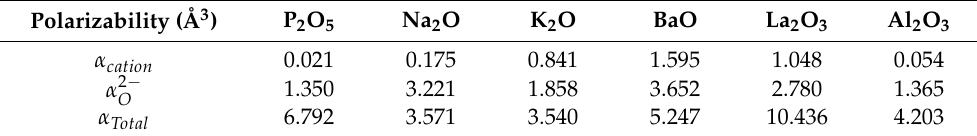
Table 3. Polarizabilities of ions used for local index calculations in the samples upon FLIER.